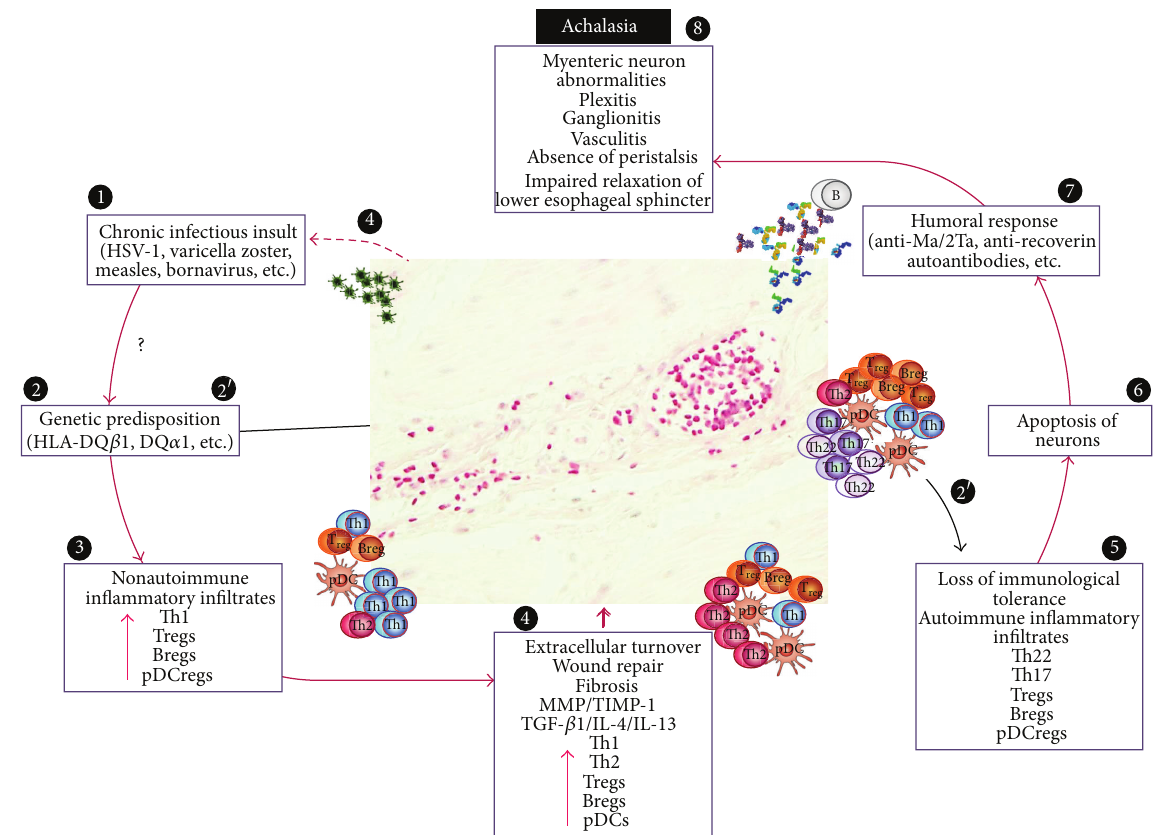
Figure 8: Proposed model of achalasia pathophysiology. (1) Active or latent infectious insult in achalasia is strongly suggested by several studies. Some neurotropic viruses such as the herpes family of viruses have predilection for squamous epithelium and may cause ganglion cell damage that is limited to the esophagus. (2) Some individuals with genetic predisposition will develop an aggressive inflammatory response. (3) At very early stage of the disease, it is possible that inflammatory infiltrates may be predominantly composed of Th1, Th2, and regulatory cell subsets (Tregs, Bregs, and plasmacytoid dendritic cells (pDCs)). (4) Repair of tissue after injury requires orchestrated coordination of several cell types and biosynthetic processes and is coordinated by an interacting group of pro- and anti-inflammatory cytokines, fibrous extracellular matrix (ECM) proteins to replace lost or damaged tissue, and products of metabolism such as oxygen radicals. The most prominent profibrogenic cytokines are TGF 𝛽 , IL-4, and IL-13. ECM also mediates cellular crosstalk and does so in two ways. Newly deposited ECM is then rebuilding over time to emulate normal tissue. Matrix proteinases and their inhibitors (TIMPs) also are important, both during wound repair, tissue remodeling, and fibrosis. (2 󸀠 , 5) If steps 1–4 happen repeatedly, chronic infection, only those individuals with genetic predisposition to develop a long-lasting autoinflammatory response will progress to develop the disease (loss of peripheral tolerance). Thus, autoinflammatory infiltrates are predominantly composed of Th22, Th17, and regulatory subpopulations. (6) Degeneration and significant loss of nerve fibers, associated with autoinflammatory infiltrates of the myenteric plexus, provide evidence of an immune mediated destruction of the inhibitory neurons, not only by necrosis but also by apoptosis (Fas/FasL overexpression). (7) Autoimmune etiology of achalasia is further supported by the presence of anti-myenteric autoantibodies in sera. (8) Pathophysiologically, achalasia is cause by autoinflammation, degeneration of nerves in the esophagus, plexitis, abnormalities in microvasculature, ganglionitis, and finally by the loss of inhibitory ganglion in the myenteric